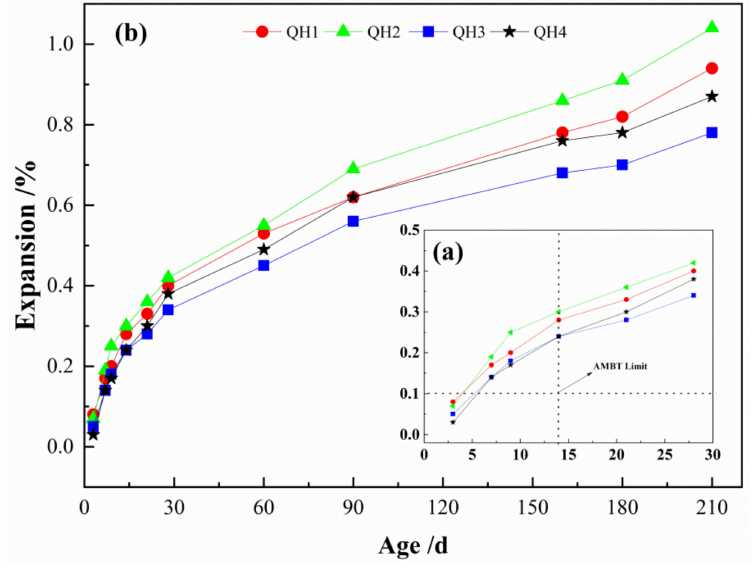
Figure 6. Expansion rate of sands in accelerated mortar bar tests (AMBT): ( a ) short-term and ( b ) long term.